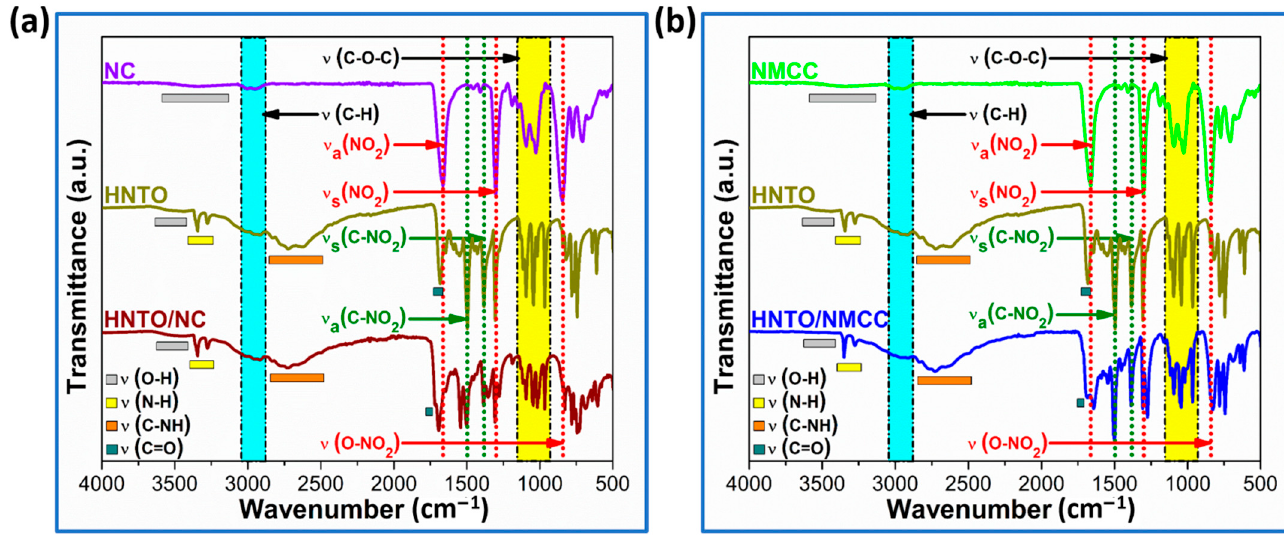
Figure 3. FTIR spectra of ( a ) HNTO/NC composite and its single components; ( b ) HNTO/NMCC composite and its single components.